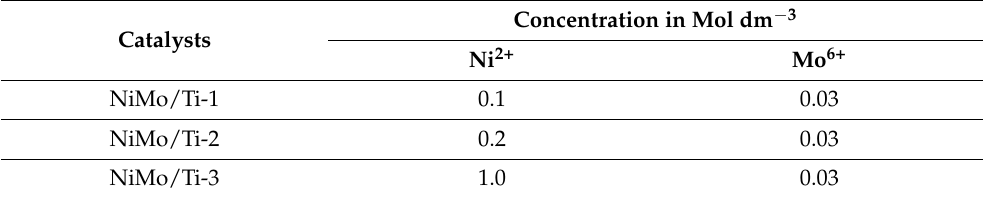
Table 1. Composition of the electrochemical bath. Catalysts